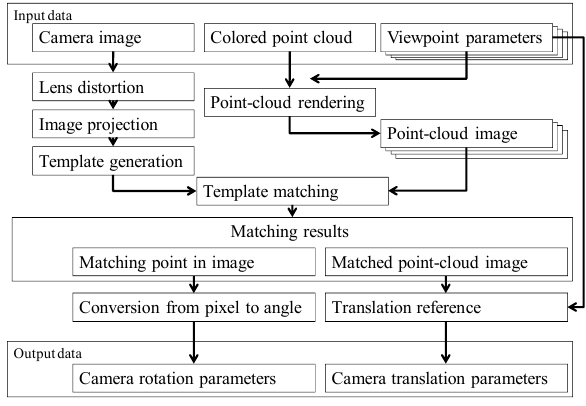
Figure 1. Processing flow